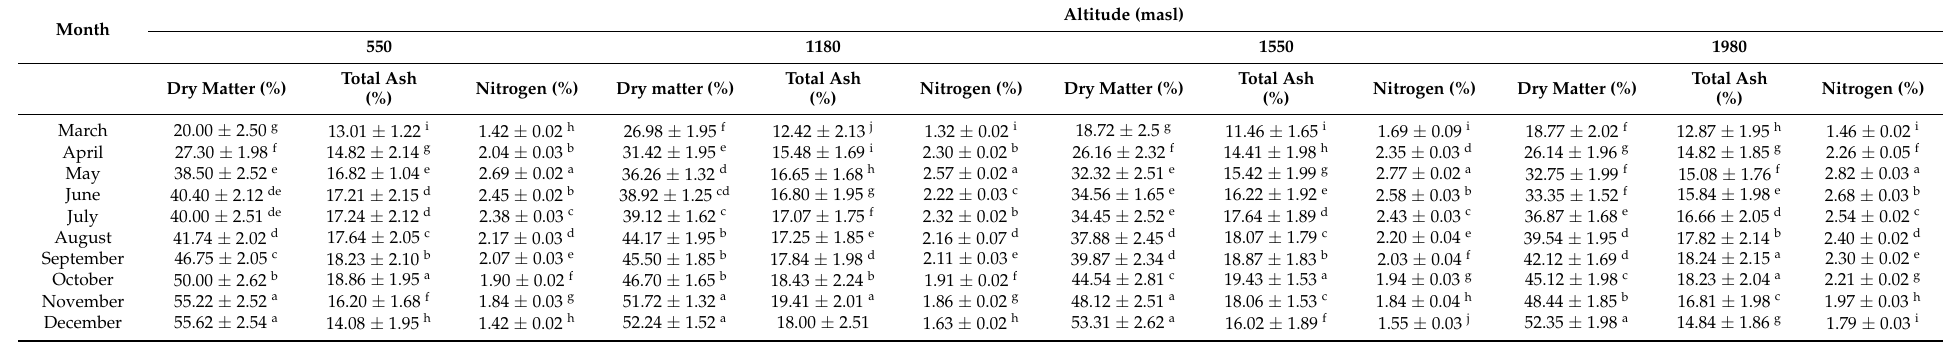
Table A1. Altitudinal and monthly variation in dry matter (DM), total ash (%), and nitrogen (%) in C. australis foliage ( ± SD). Means followed by the same letter are not significantly ( p < 0.05) different.